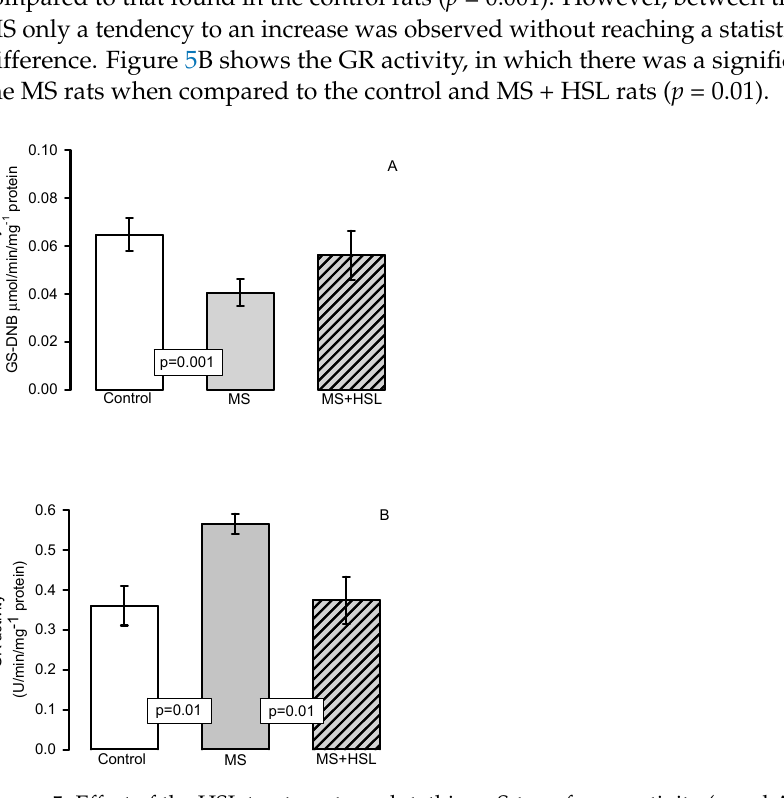
Figure 5. Effect of the HSL treatment on glutathione-S-transferase activity (panel A ) and glutathione reductase (GR) activity (panel B ) in kidney homogenate. Abbreviations: MS = metabolic syn- drome, MS + HSL = metabolic syndrome plus Hibiscus sabdariffa L., GST = glutathione-S-transferase, GR = glutathione reductase. Data are expressed in means ± SE, ( n = 8, rats in each group). Statistical significance was determined by one-way ANOVA test, followed by Tukey’s post hoc test.